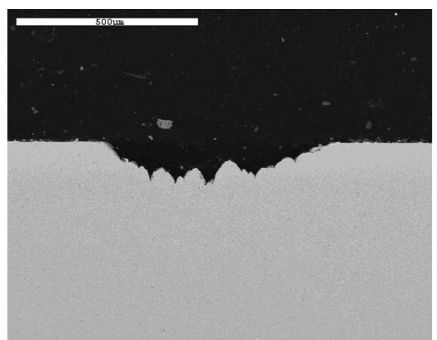
Figure 4: Macrograph of sample machined by femtosecond laser ( V = 1 mm/s).